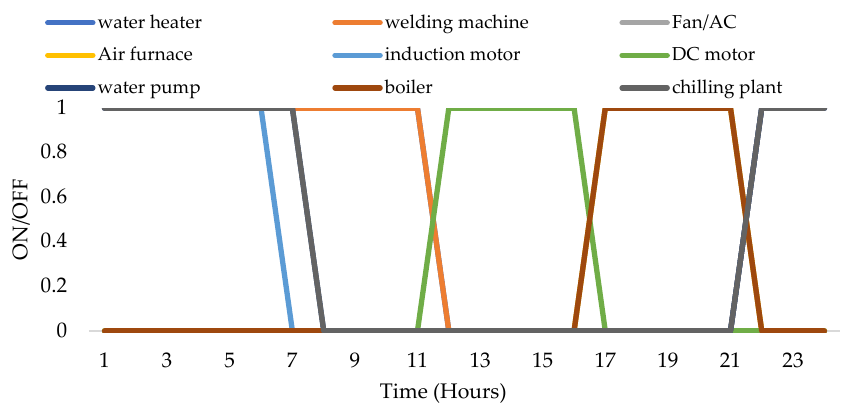
Figure 21. ON/OFF period of individual devices.